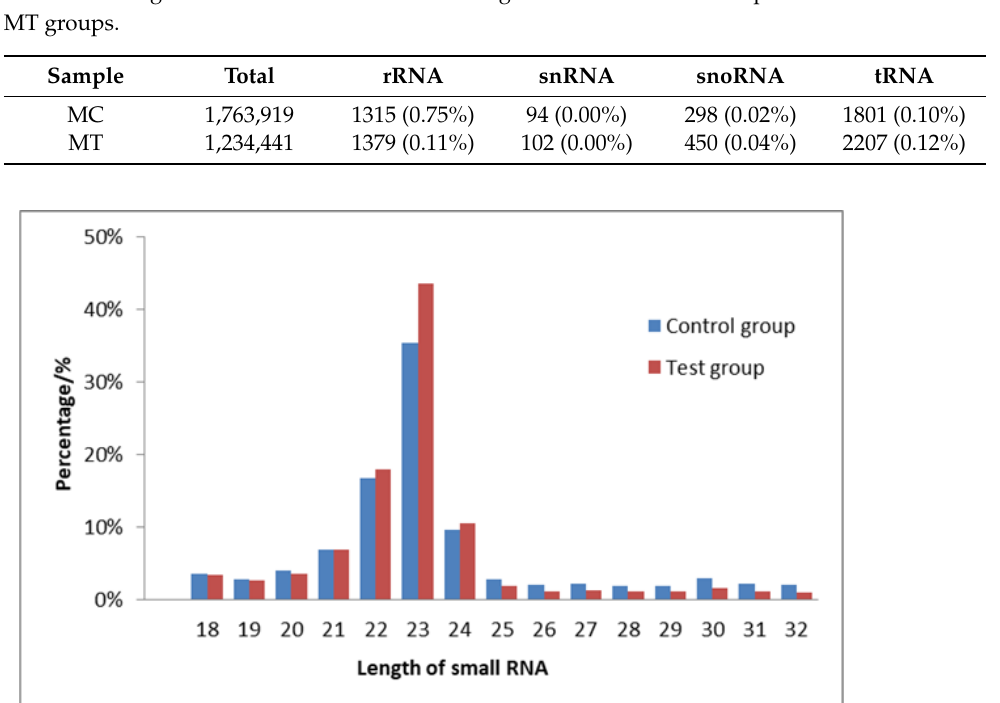
Figure 2. Distribution of small RNA length in the MC and the MT groups.